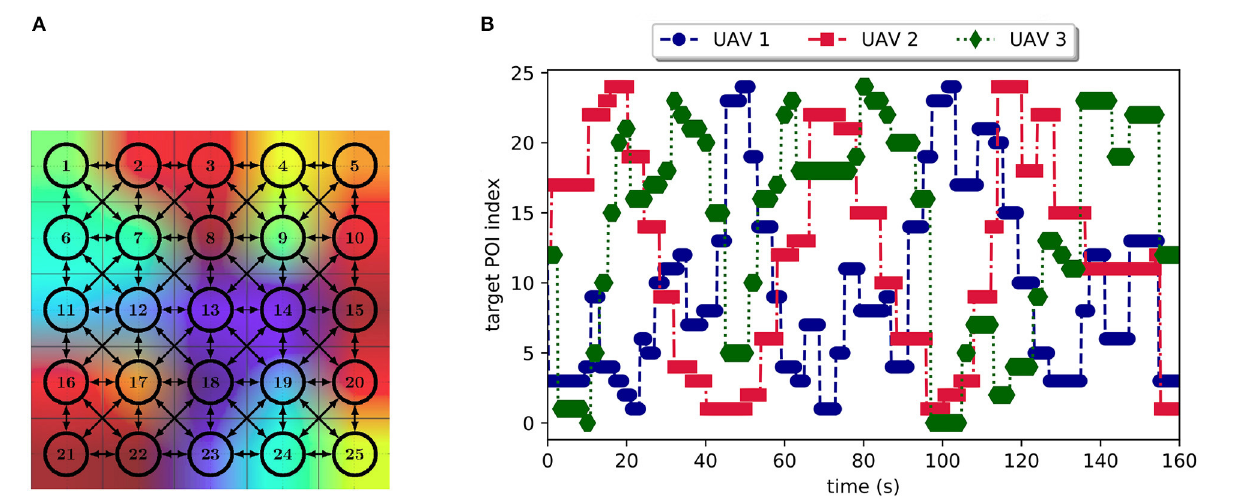
FIGURE 9 | Scenario being considered during the experimental flight. The heatmap in background of (A) illustrates a time picture during the flight, showing the time elapsed since the last UAV visit. (A) Diagram of POI locations and possible paths between them used for the flight experiments. (B) Experiment timeline showing the different POIs visited by the UAVs. Markers show the total time elapsed to decide about POI destination and to reach the target